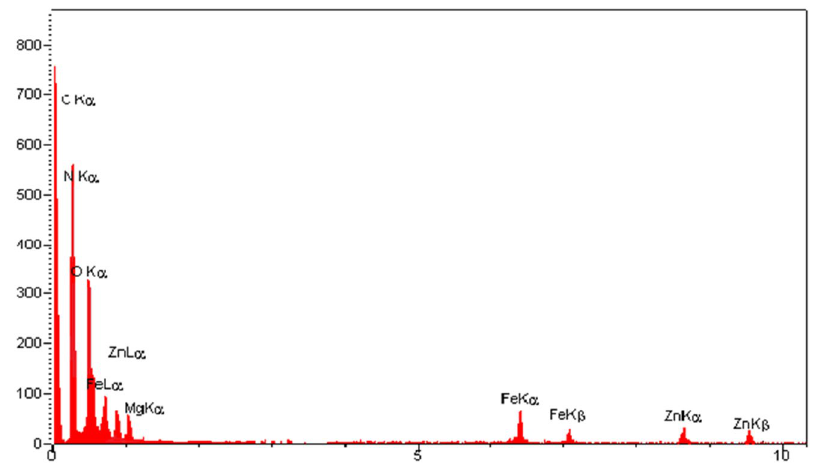
Figure 5. EDX spectrum of ZIF-8/GO/MgFe 2 O 4 /TC.